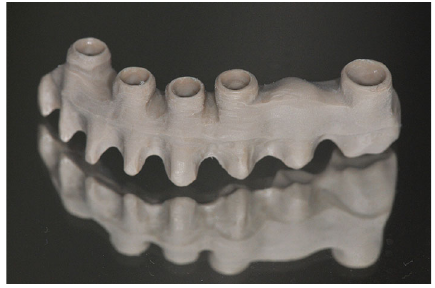
Figure 11: Modi fi ed PEEK